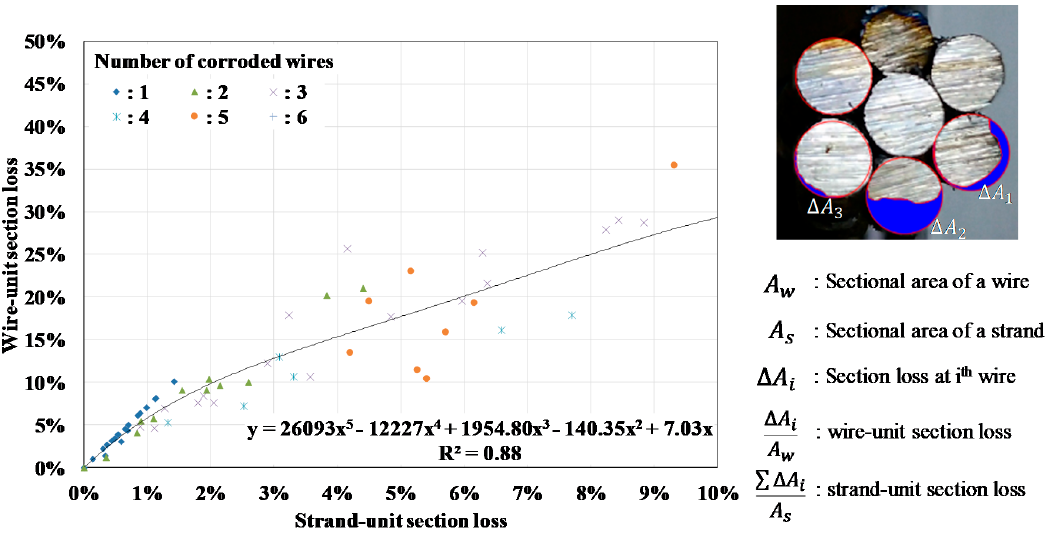
Figure 9. Relation between wire-unit section loss of the most corroded wire and strand-unit section loss, considering the number of corroded wires.